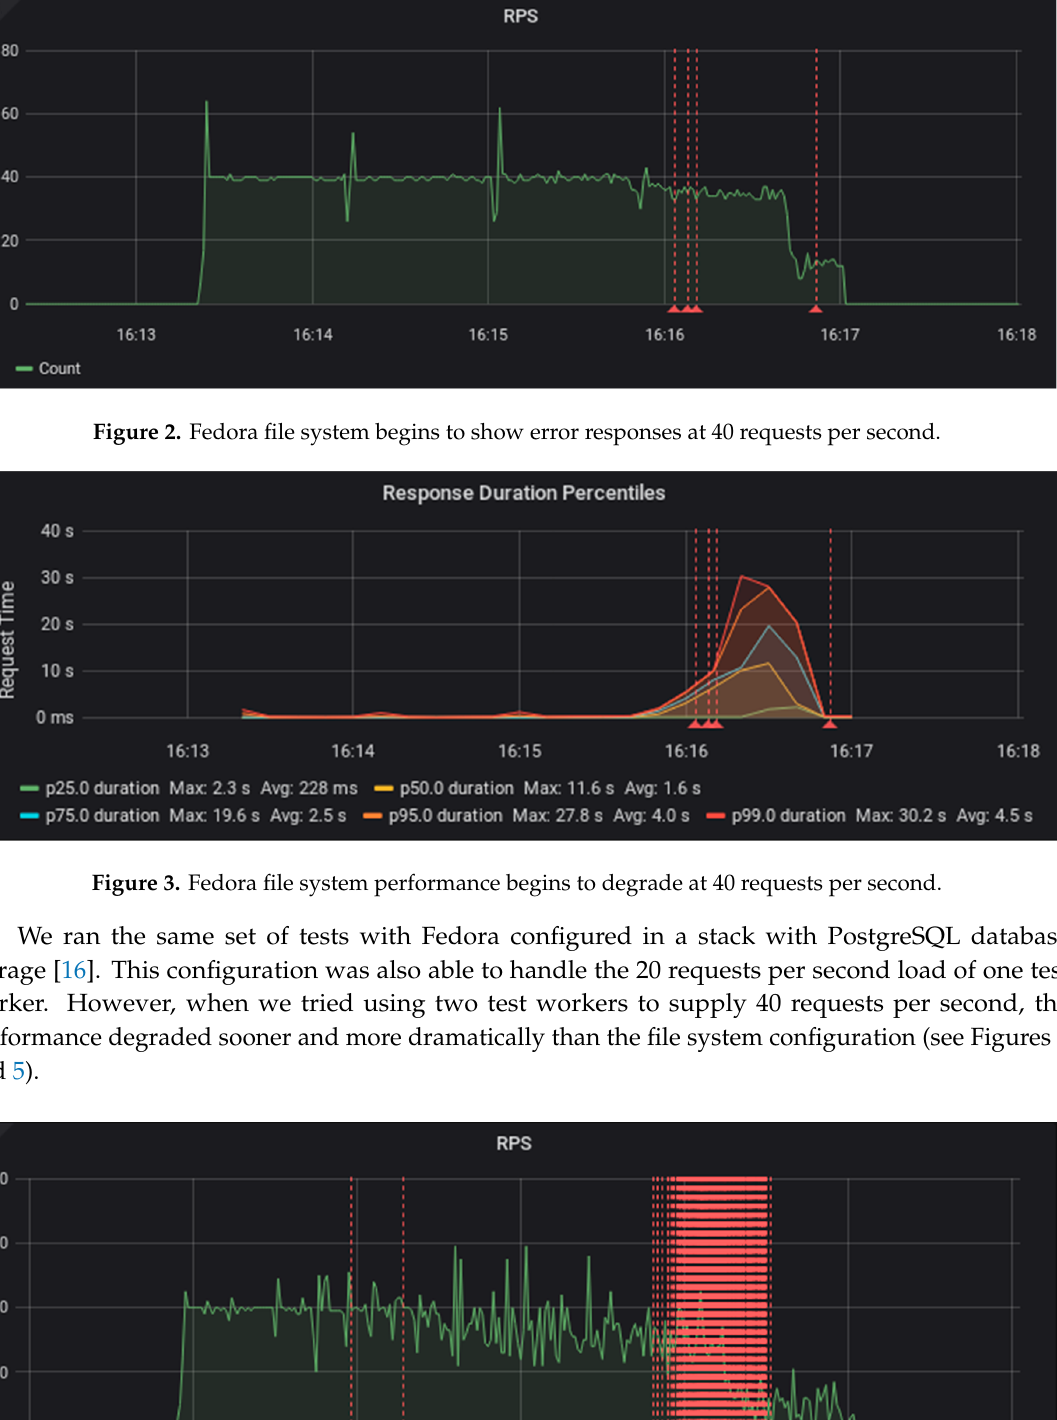
Figure 5. Fedora PostgreSQL system performance degrades at 40 requests per second. By looking into the system logs, we were able to determine that the cause of these errors was always a timeout while the system waited for a database connection. With a limited number of database connections, it seems like Fedora operations were not releasing these connections fast enough to keep up with requests. Moving on to the Trellis LDP system, let us look at the performance with PostgreSQL database storage. This system was able to handle the load from a total of 15 test workers (300 requests per second) while maintaining an average response time of just 51 milliseconds and a maximum response time of two and a half seconds (See Figure 6). Figure 6. Trellis PostgreSQL system serves 300 requests per second. When we pushed our test load up to 16 workers (320 requests per second), we saw performance degrade and were able to produce error responses from the Trellis PostgreSQL stack [17]. We have not yet investigated the root cause for this pattern (See Figure 7).